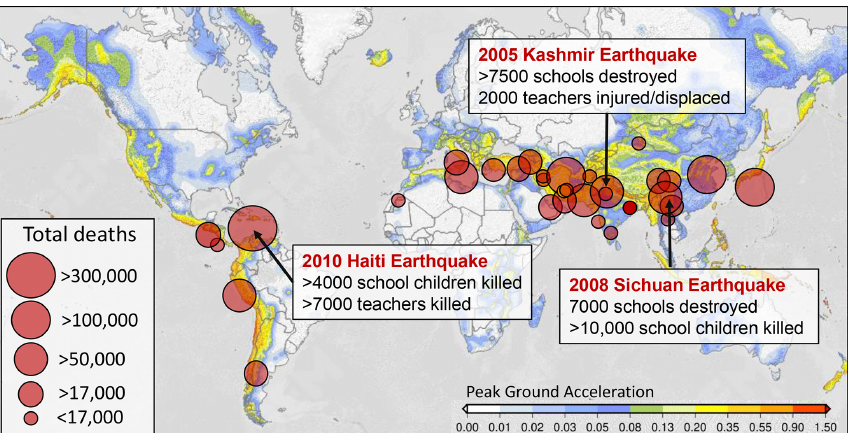
Figure 1. Significant earthquakes from the National Geophysical Data Center/World Data Service (last access: 3 March 2020) superimposed on the Global Seismic Hazard map of Pagani et al. (2018). Impact details of recent earthquakes discussed in text are shown in white